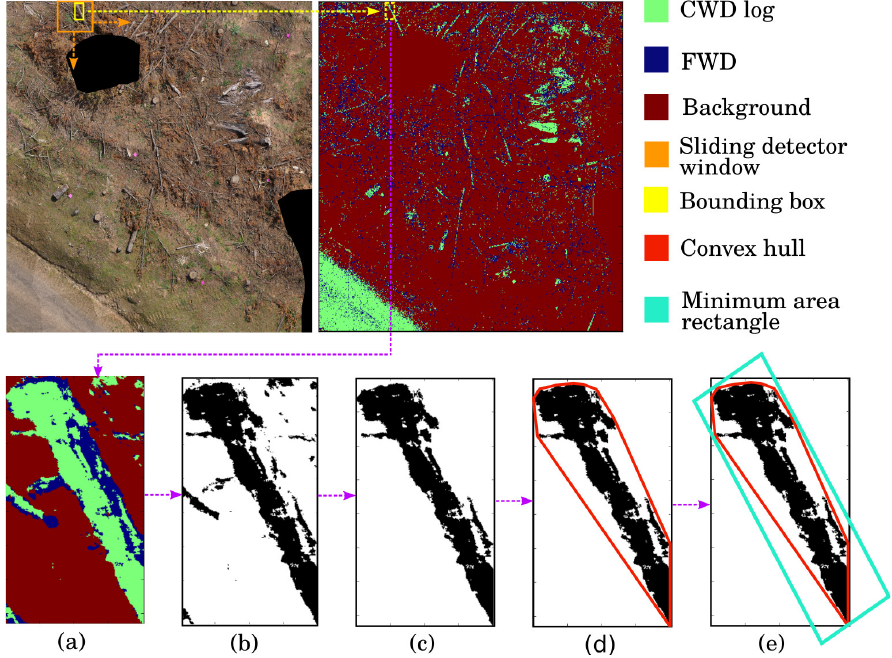
Figure 6. The rectangle fitting process. An image ( a ) is extracted from the segmented mosaic using a bounding box from the Faster-RCNN detector. The image is binarized ( b ) so that CWD is black and FWD and background are white. Connected components with fewer than 1000 pixels, likely to be false positives, are removed ( c ). A convex hull is fitted around the remaining CWD connected components ( d ), and the rectangle with the smallest area that fits around the convex hull is fitted ( e ). After merging, if there is a sufficient amount of overlap between resulting rectangles (greater than 0.75% of the smaller rectangle), this is likely due to two distinctly similar groups of rectangles that correspond to the same rectangle, often resulting in a smaller rectangle within a larger one. In this case, the rectangle with the smaller area is removed (Figure 7d). Finally, abnormally large rectangles resulting from the merging process (those with no side shorter than 300 pixels i.e., 101.7 cm) are removed. The diameter threshold for removing large rectangles in this step should be higher than for the previous large rectangle removal step. This is because of the possibility of merged rectangles being fitted to logs that are slightly curved or bent such that their apparent diameter is larger. The remaining rectangles should each correspond to distinct logs, and their width and height should align with the length and diameter of the logs. Once a rectangle has been fitted to each CWD log, its volume can be estimated using Equation